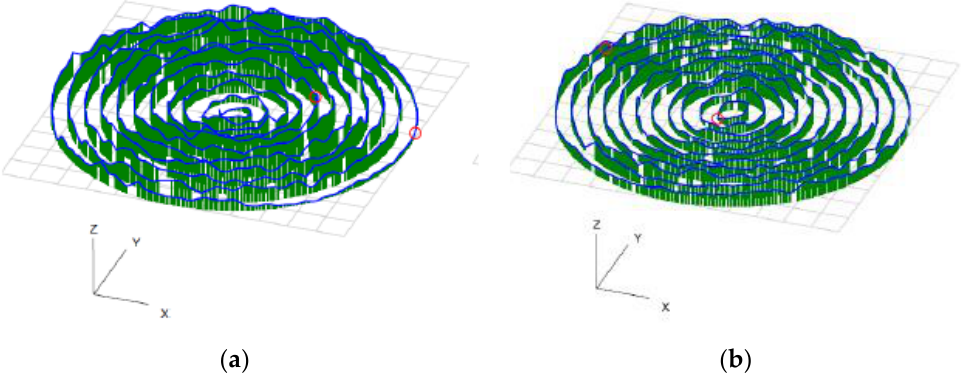
Figure 22. Flatness deviations ( a ) constant Z strategy; ( b ) circular Pocket strategy.